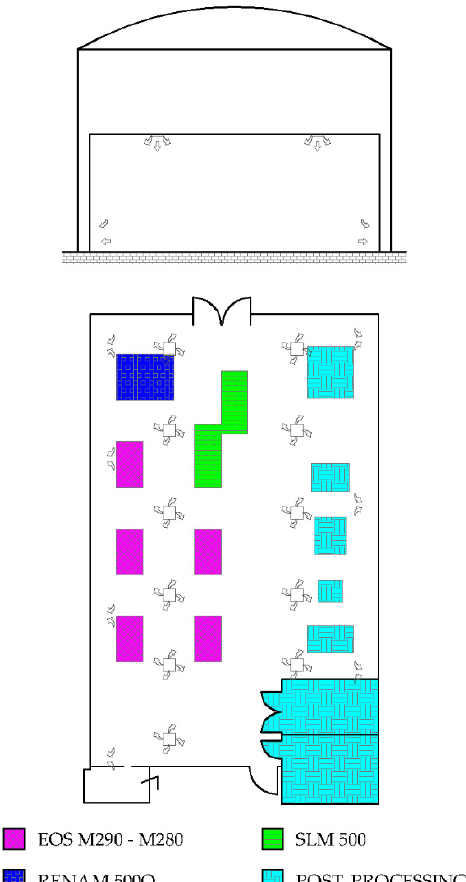
Figure 1. Graphic representation of the metal-additive area.